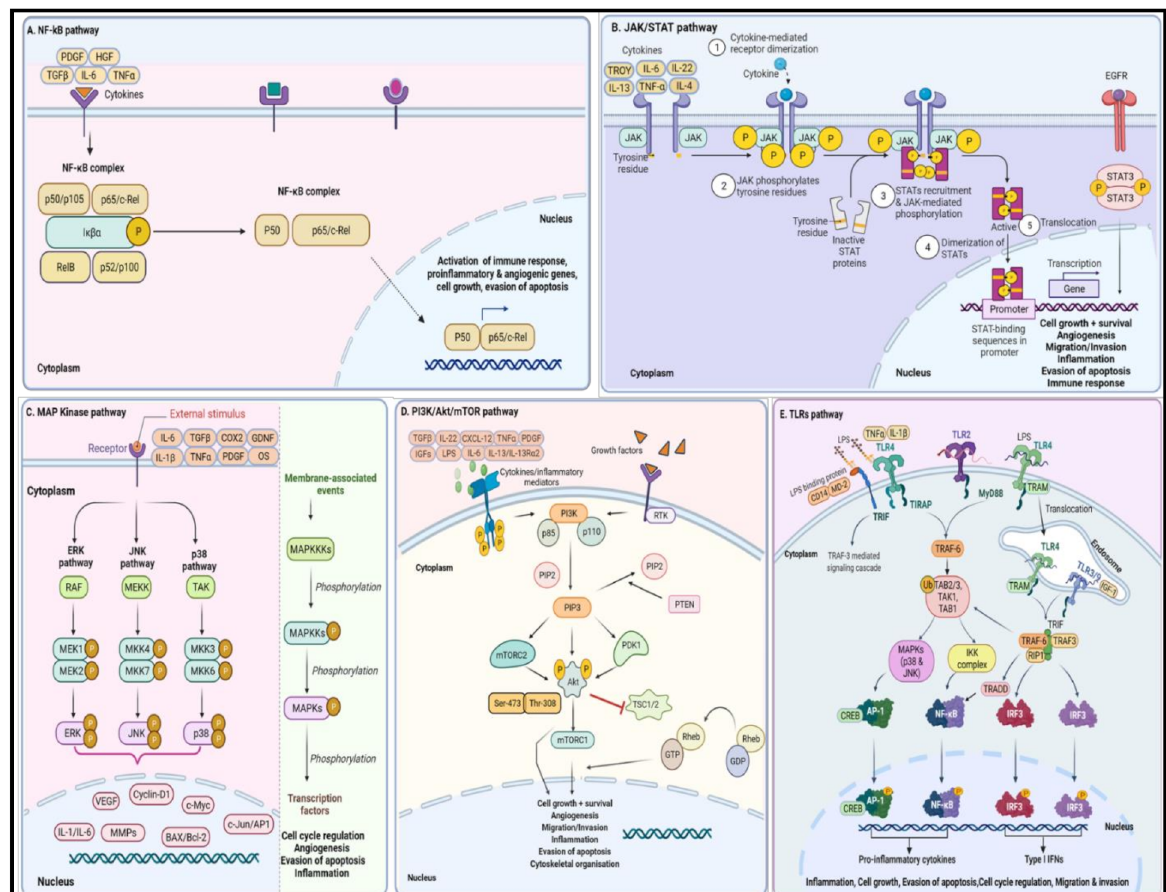
Figure 2. Representation of the key signaling pathways involved in the inflammation-induced glioma genesis. ( A ) NF- κ B pathway; ( B ) JAK/STAT pathway; ( C ) MAP Kinase pathway; ( D ) PI3K/Akt/mTOR pathway; ( E ) TLRs pathway. NF- κ B: Nuclear factor kappa-light-chain-enhancer of activated B cells; JAK/STAT: Janus kinase-signal transducer and activator of transcription; MAPK: Mitogen-activated protein kinase; PI3K/Akt/mTOR: Phosphatidylinositol-3-kinase-mammalian target of rapamycin; TLRs: Toll-like receptors; IL-1 β , -4, -6, -13, -22: interleukins-1 β , -4, -6, -13, -22; CXCL-12: chemokine (C-X-C motif) ligand-12; TNF- α : tumor necrosis factor- α ; COX-2: cyclooxygenase-2; PDGF: platelet-derived growth factor; TGF β : transforming growth factor β ; HGF: hepatocyte growth factor; OS: oxidative stress; TROY: tumor necrosis factor receptor superfamily member 19; pSTAT3: phosphorylated signal transducer and activator of transcription 3; GDNF: glial cell-derived neurotrophic factor; I κβα : inhibitor of kappa B alpha; EGFR: epidermal growth factor receptor; ERK: extracellular signal-regulated kinase; JNK: c-Jun N-terminal kinase; VEGF: vascular endothelial growth factor; MMPs: matrix metalloproteinases; Bax/Bcl-2: Bcl-2-associated X protein , B-cell lymphoma 2; AP-1: activator protein- 1; IGFs: insulin-like growth factors; LPS: lipopolysaccharide; PI3K: phosphoinositide 3 kinase; Akt: protein kinase B; PDK: 3-phosphoinositide-dependent kinase 1; PIP2/3: phosphatidylinositol-4, 5-bisphosphate/ phosphatidylinositol-3, 4, 5-triphosphate; mTORC1/mTORC2: mechanistic target of rapamycin complex 1 and 2; TSC1/2: tuberous sclerosis complex 1/2; PTEN: phosphatase and tensin homolog: RTK: receptor tyrosine kinase; Rheb: Ras homolog enriched in brain; CD14: cluster of differentiation 14; MD2: myeloid differentiation factor 2; MyD88: myeloid differentiation factor 88; TIRAP: TIR-containing adaptor protein; TRIF: Toll/IL-1R domain-containing adapter inducing interferon- β ; TRAF6, -3: TNF receptor-associated factor 6, -3; TRAM: TRIF-related adaptor molecule; RIP1: receptor-interacting protein 1; TAB-1, 2/3: TAK1-binding protein-1, 2/3; TAK1: TGF- β -activated kinase; TRADD: TNF receptor type 1-associated DEATH domain protein; IGF-1: insulin growth factor-1; CREB: cAMP response element binding protein; IRF3: interferon regulatory factor